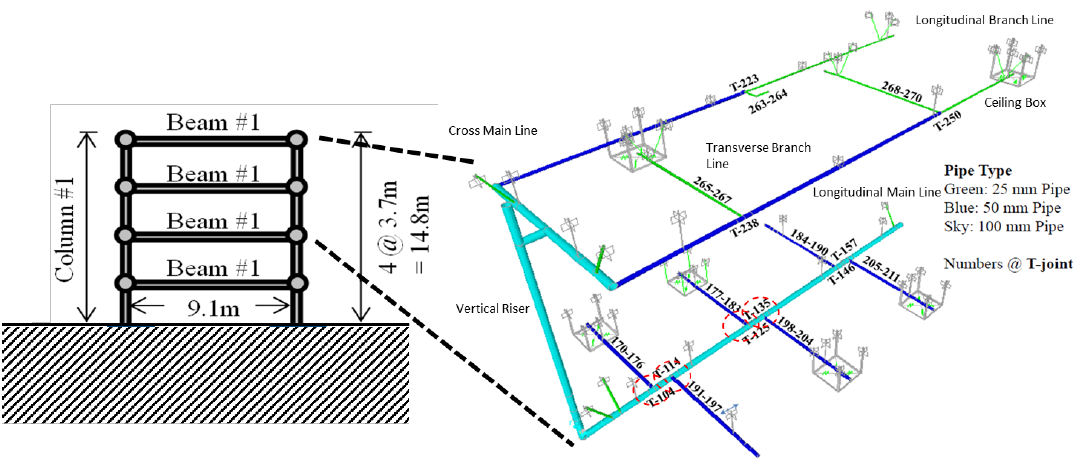
Figure 4. Building–piping coupled structural model.